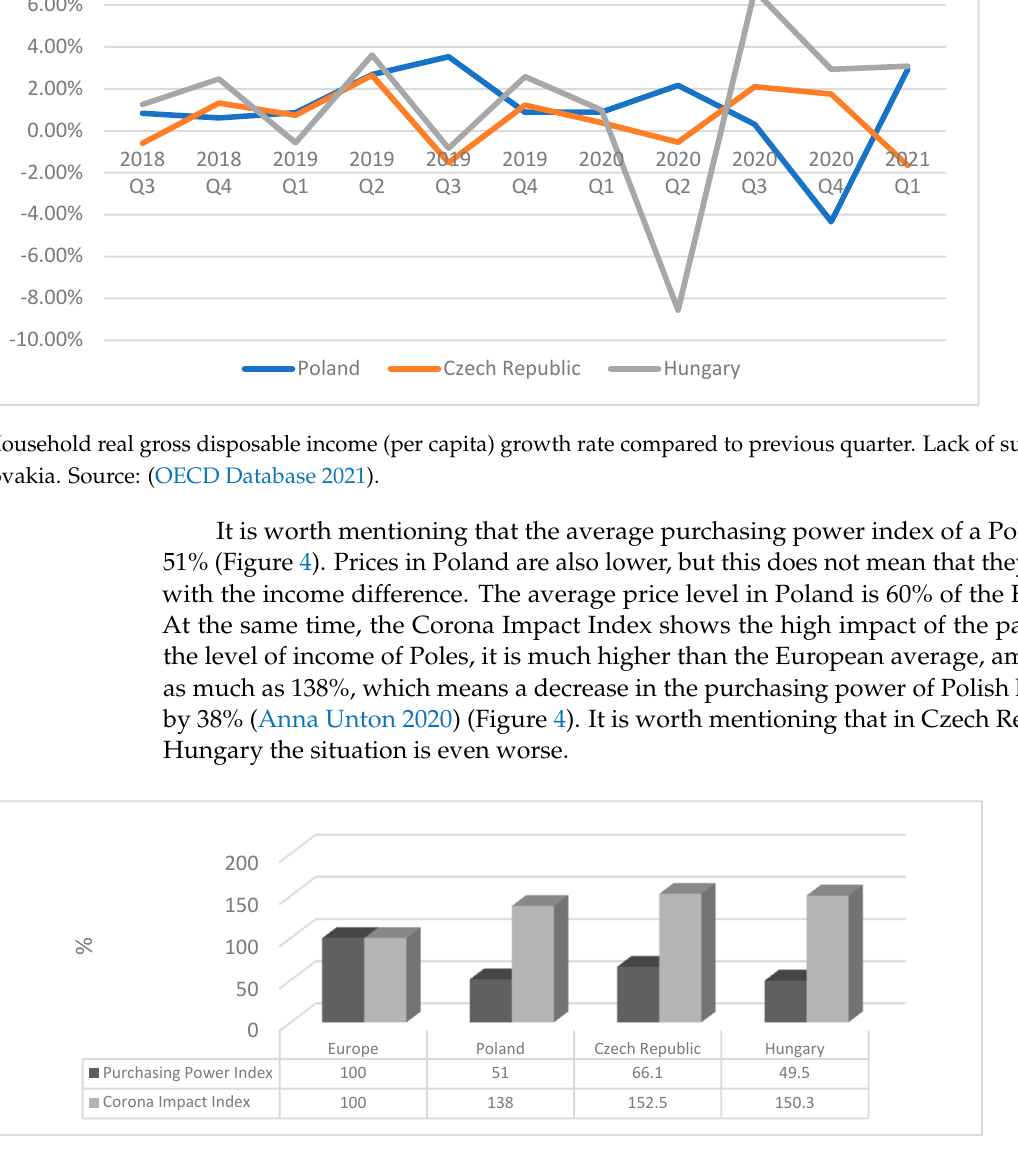
Figure 4. Purchasing Power Index and Corona Impact Index (Europe—ranking 2020). Lack of sufficient data for Slovakia. Source: (Muranyi and Richter 2020; GfK Purchasing Power Europe 2020, pp. 2–3; Anna Unton 2020).